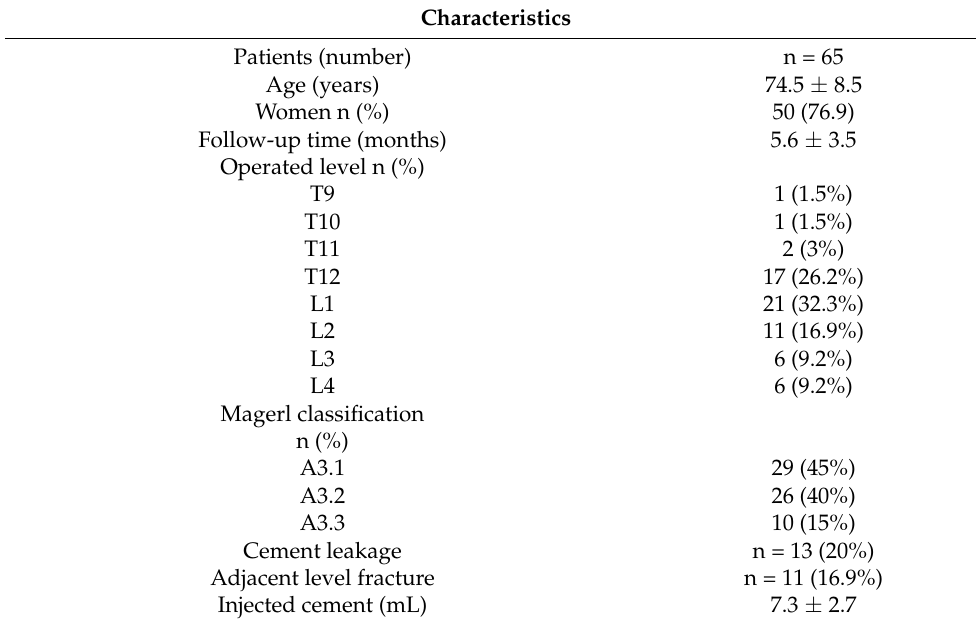
Table 1. Baseline patient characteristics.